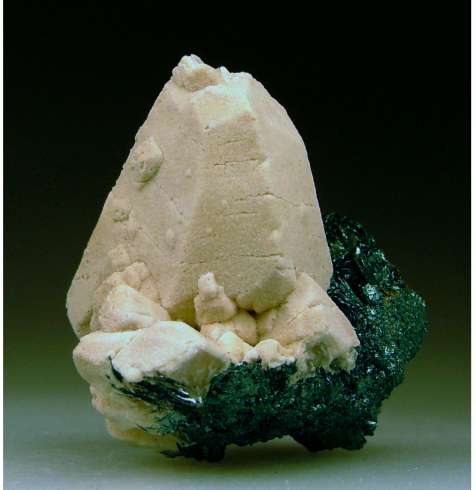
Figure 11. Calcite and hematite, Chub Lake prospect. 5.5 cm. Chamberlain Collection, NYSM C12216.